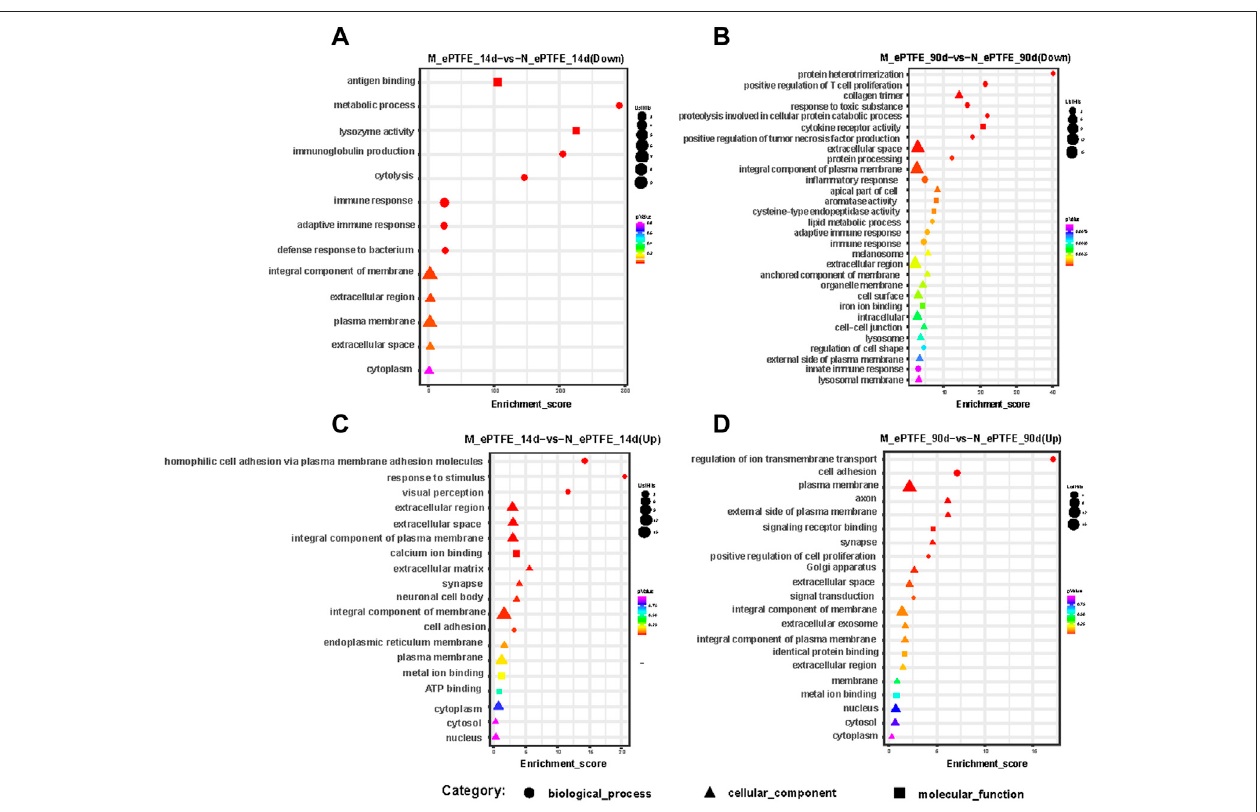
FIGURE 11 | Bubble diagrams of top gene ontology (GO) terms in the modi fi ed expanded polytetra fl uoroethylene (M-ePTFE) vs unmodi fi ed ePFTE (N-ePTFE) comparison group at 14 days (A) downregulated; (C) upregulated) and 90 days (B) downregulated, (D) upregulated) post-implantation. The bubble shapes indicate different categories of GO terms, while the color and diameter indicate p values and numbers of differentially expressed mRNAs, respectively.